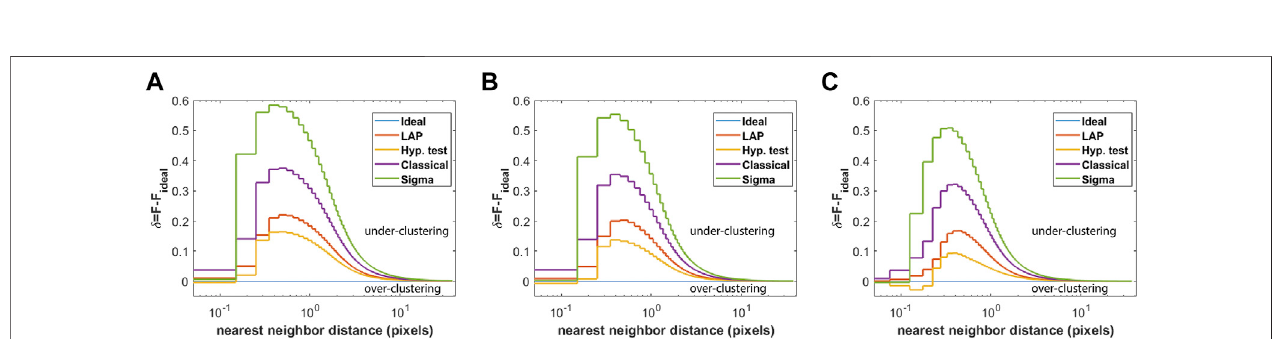
FIGURE 2 | Deviation of the nearest-neighbor distance CDF from that of the ideal frame-connection result ensembled over multiple uniform emitter simulations, where nearest-neighbors are restricted to appear within fi ve frames of one another. The green line corresponds to the revised classical method, the purple line to the classical method, the yellow line to the hypothesis test method, the red-orange line to the LAP-FC method, and the blue line is the δ (cid:2) 0 baseline. The number of simulations and initial densities were varied as (A) 40 simulations with ρ 0 (cid:2) 5 emitters/pixel 2 , (B) 20 simulations with ρ 0 (cid:2) 10 emitters/pixel 2 , and (C) 10 simulations with ρ 0 (cid:2) 20 emitters/pixel 2